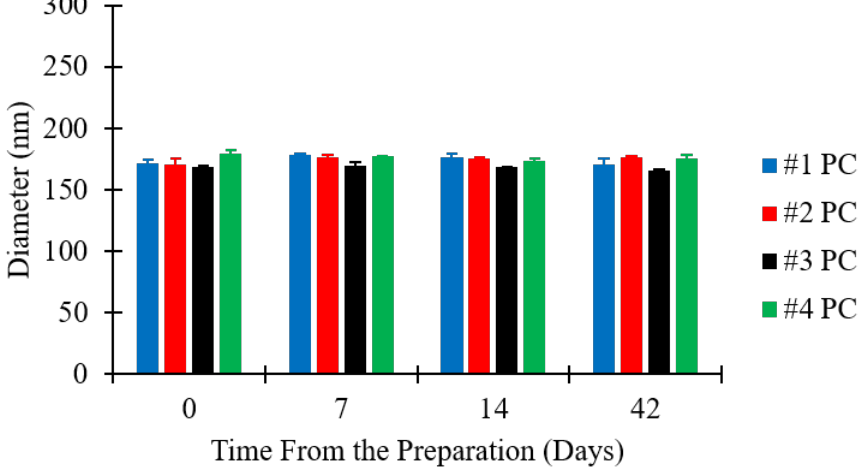
Figure 5. Dimensional stability of liposomes as a function of FRR. Data represent the means of three measurements with corresponding standard deviations. Refer to Table 1 (batch code #1 PC to #4 PC) for the corresponding experimental conditions, lipid compositions, and numerical data of mean values and standard deviations.